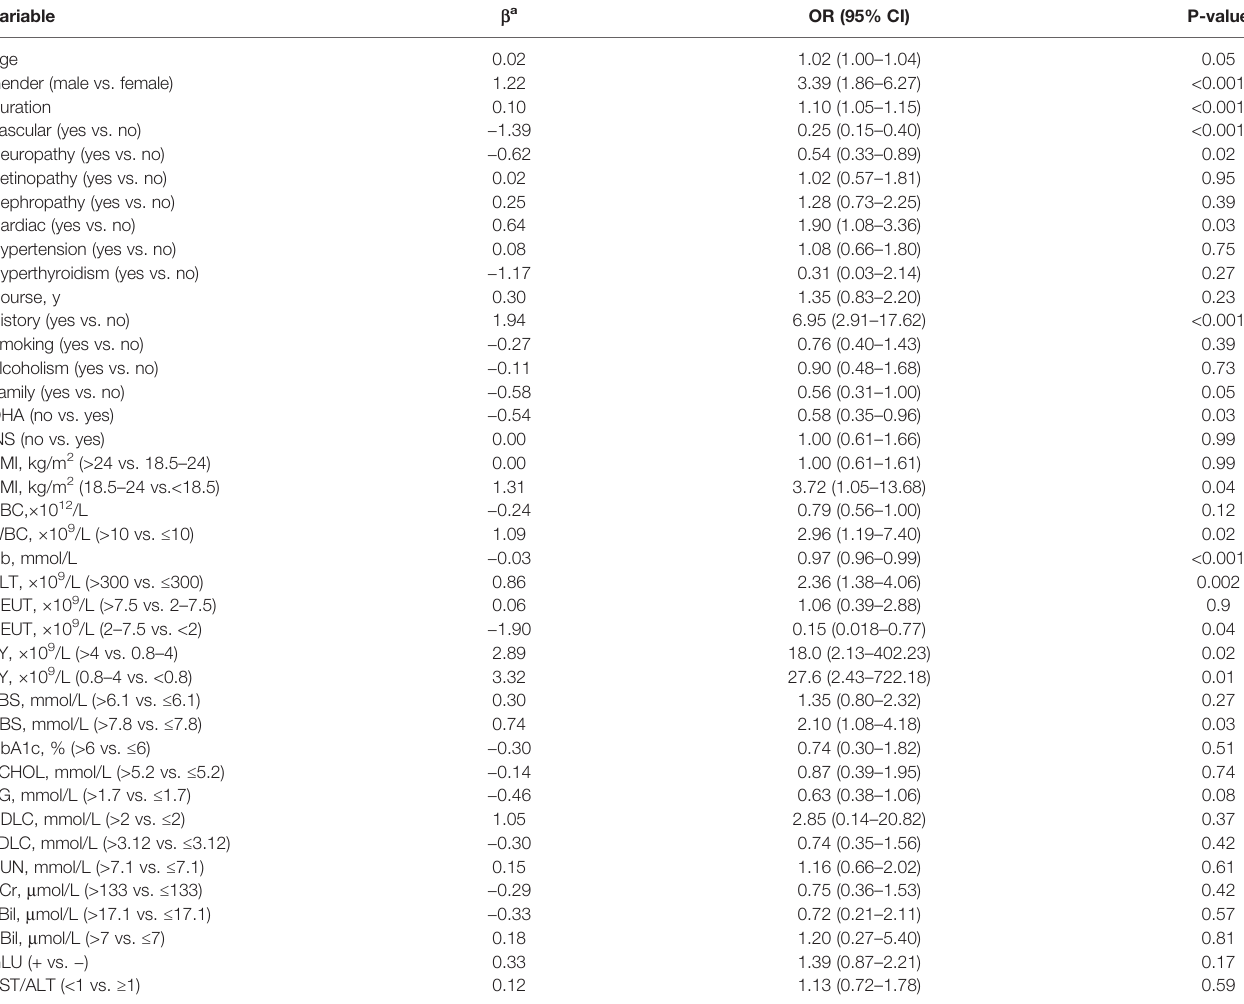
TABLE 3 | Multivariate logistic regression analysis of DFU based on preoperative data in the training cohort.